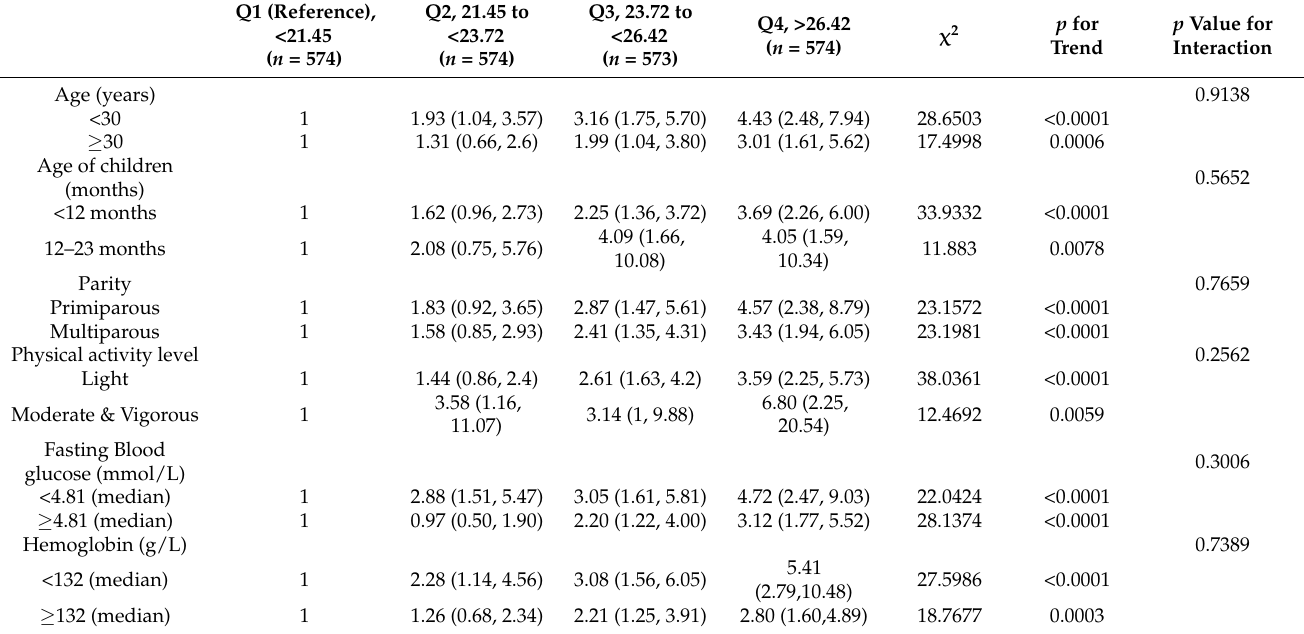
Table 4. Stratified analyses of dyslipidemia risk and BMI by age, age of children, firstborn (yes/no), physical activity level, blood glucose, and